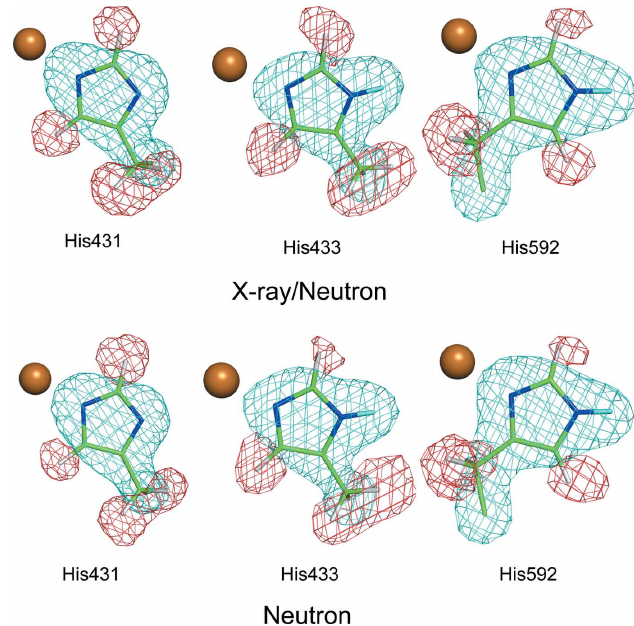
Figure 4 Assigned models of Cu 2+ -coordinated His residues refined by X-ray/ neutron analysis (top) and neutron analysis (bottom). F o (cid:3) F c polder omit SLD maps, calculated without contributions from His431, His433 and His592, are contoured with positive (cyan) and negative (red) contours of 4.0 (cid:5) and (cid:3) 3.0 (cid:5) , respectively. The orange sphere represents the Cu